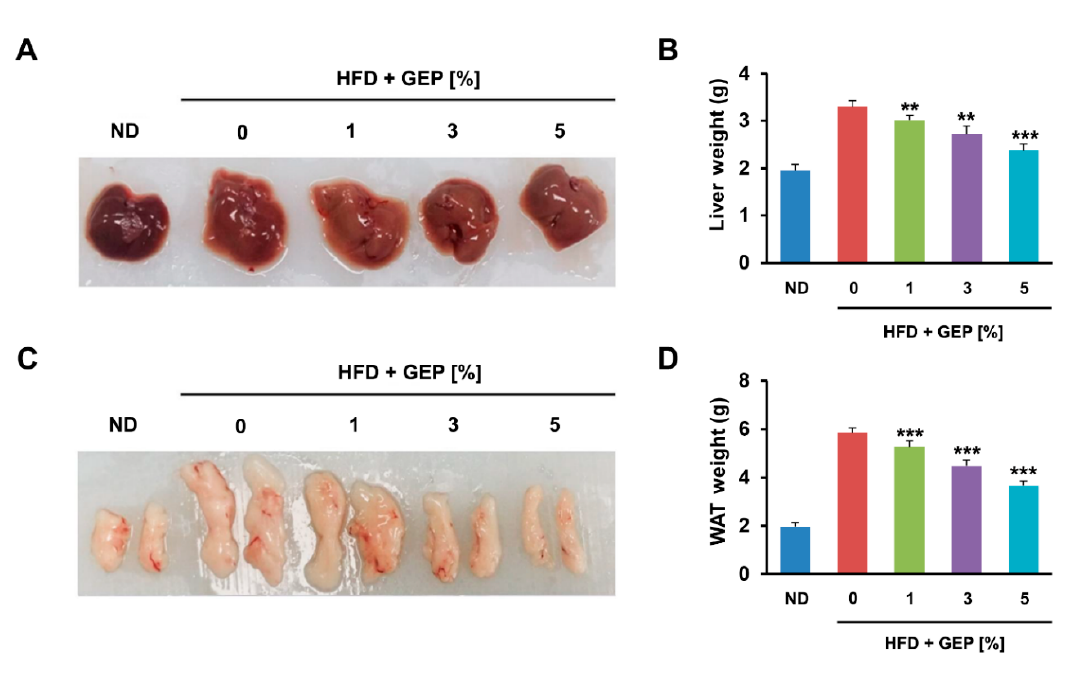
Figure 2. GEP decreases the size and weight of liver and WAT. ( A ) Liver size, ( B ) liver weight, ( C ) epididymal WAT size, and ( D ) total WAT weight measured using a microbalance. Data represent the mean ± SD of six to seven individual mice. Significant differences vs. the HFD group (control) were determined by one-way ANOVA; ** p < 0.01, *** p < 0.001. ND: normal chow diet group; HFD: